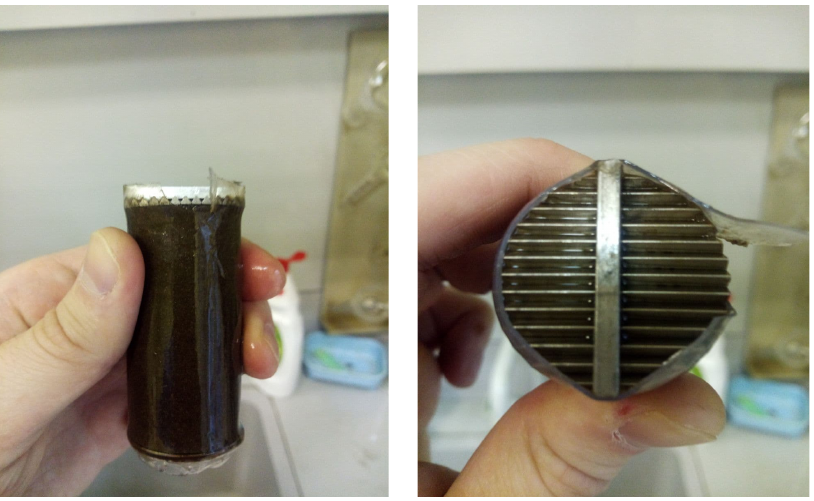
Figure 6. Bulk reservoir model with the preinstalled screen coupon (wire-wrapped screen (WWS) 200 µm).